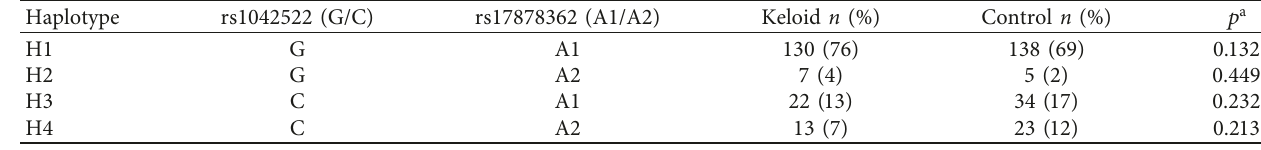
Table 2: Association analysis of TP53 haplotypes with keloid in Caucasians. Haplotype